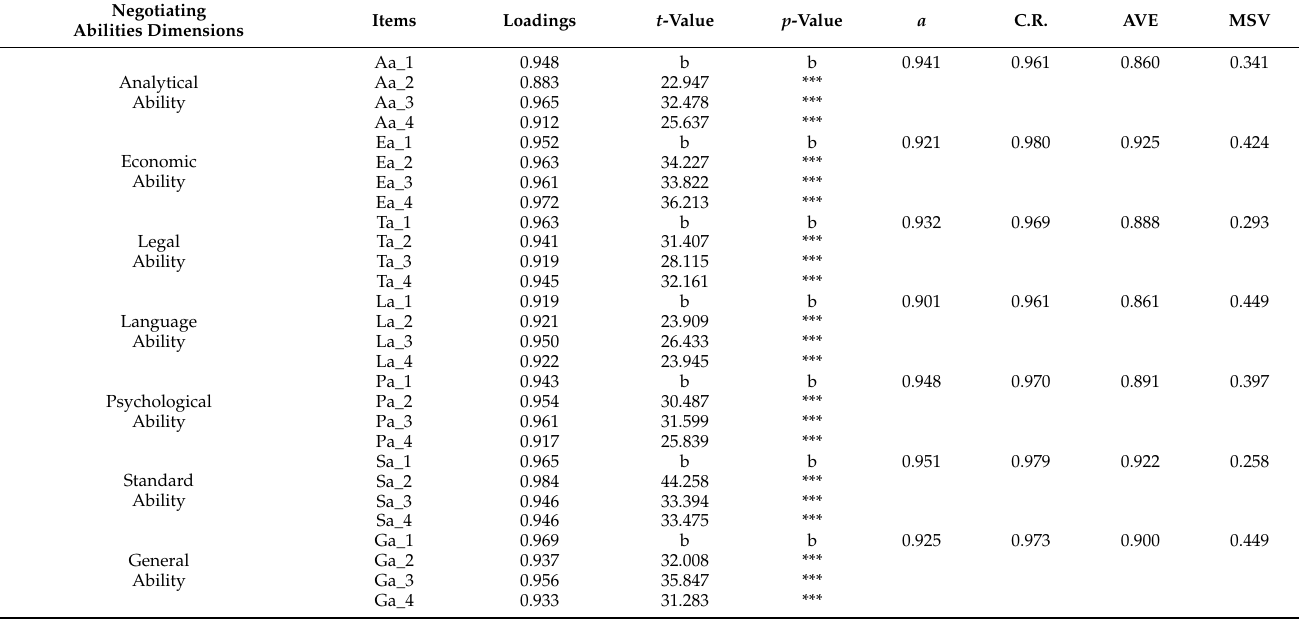
Table 5. Psychometric properties of the study